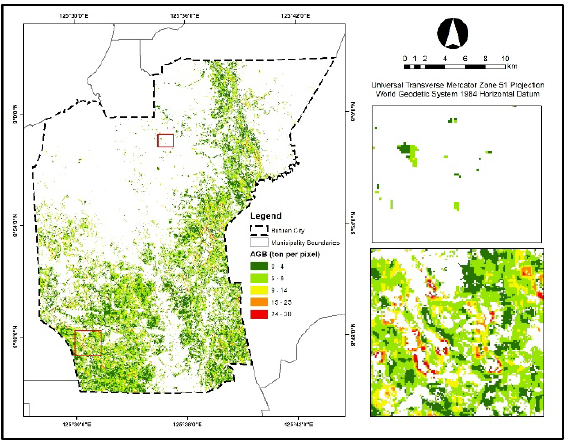
Figure 7. Scatter plot between field AGB and predicted AGB of the validation plots.